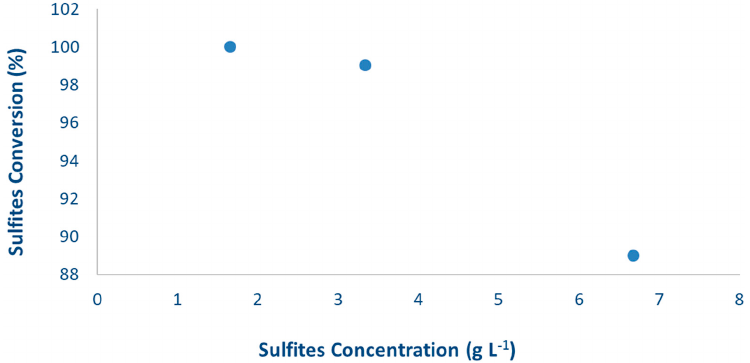
Figure 8. Sulphite conversion vs. their initial concentration after 24 h of reaction. P25 as a photocatalyst with 0.031 g·L − 1 loading and at pH = 13/14.